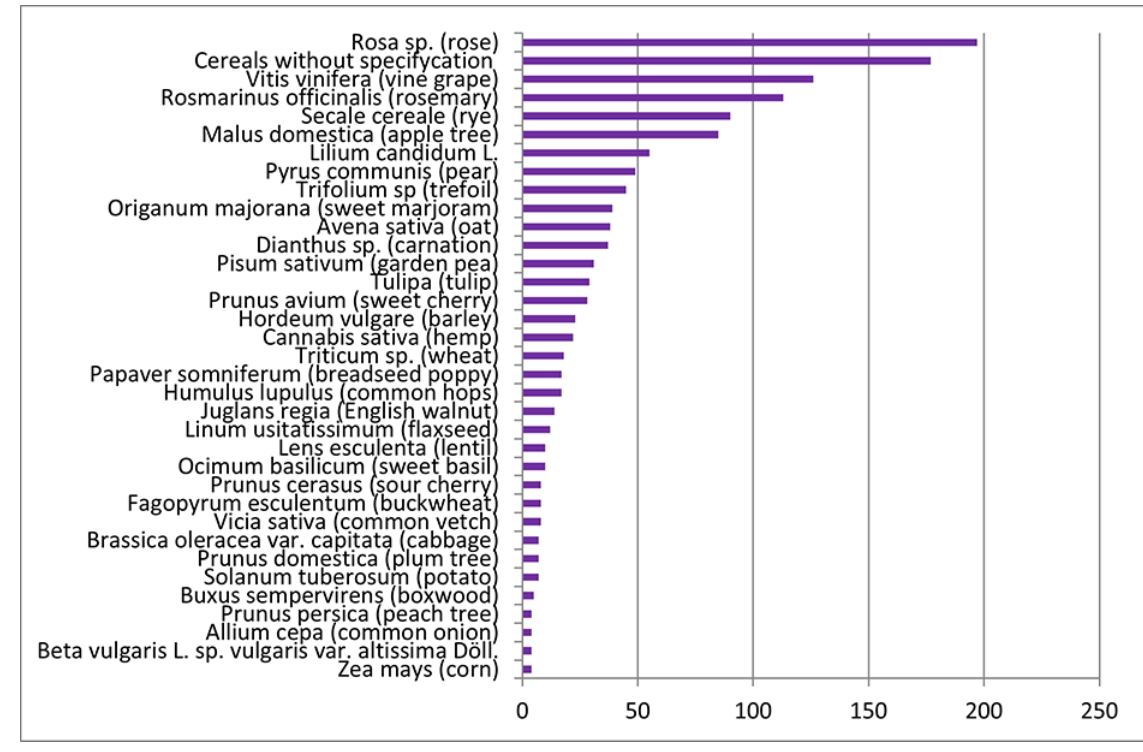
Figure 4 Representation of cultivated species with frequency ≥ 4 in Slovak folk songs.